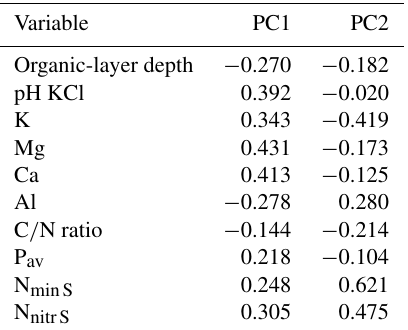
Table B2. Factor loadings of the variables in the PCA (Fig.